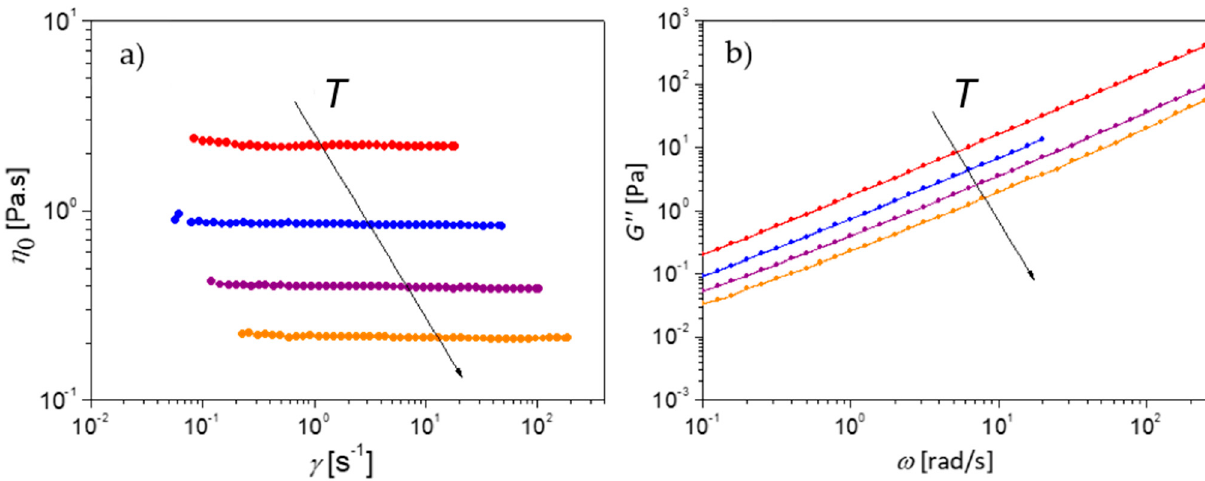
. γ and ( b ) complex